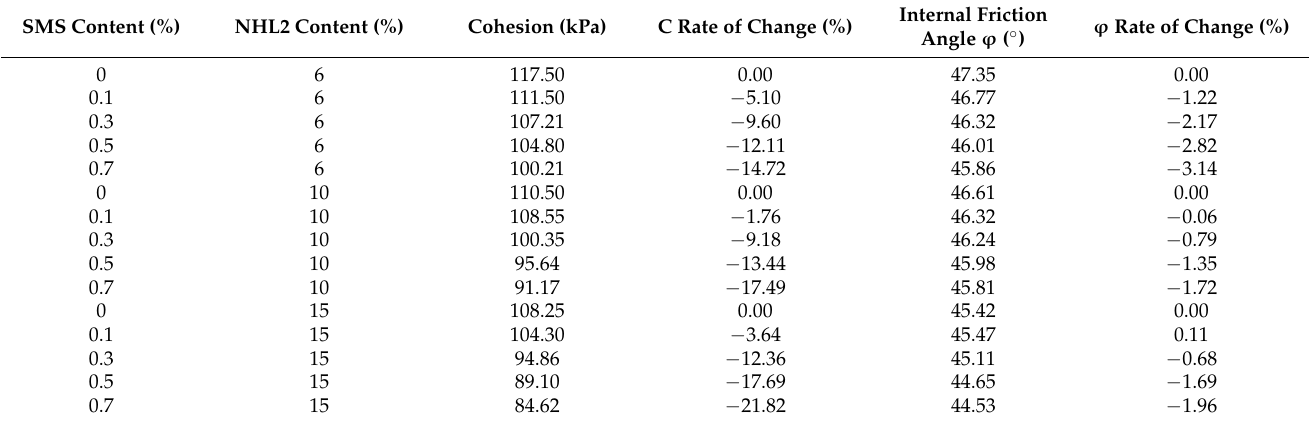
Figure 8. Variation of internal friction angle with SMS content. Table 7. Cohesion and internal friction angle of composite modified